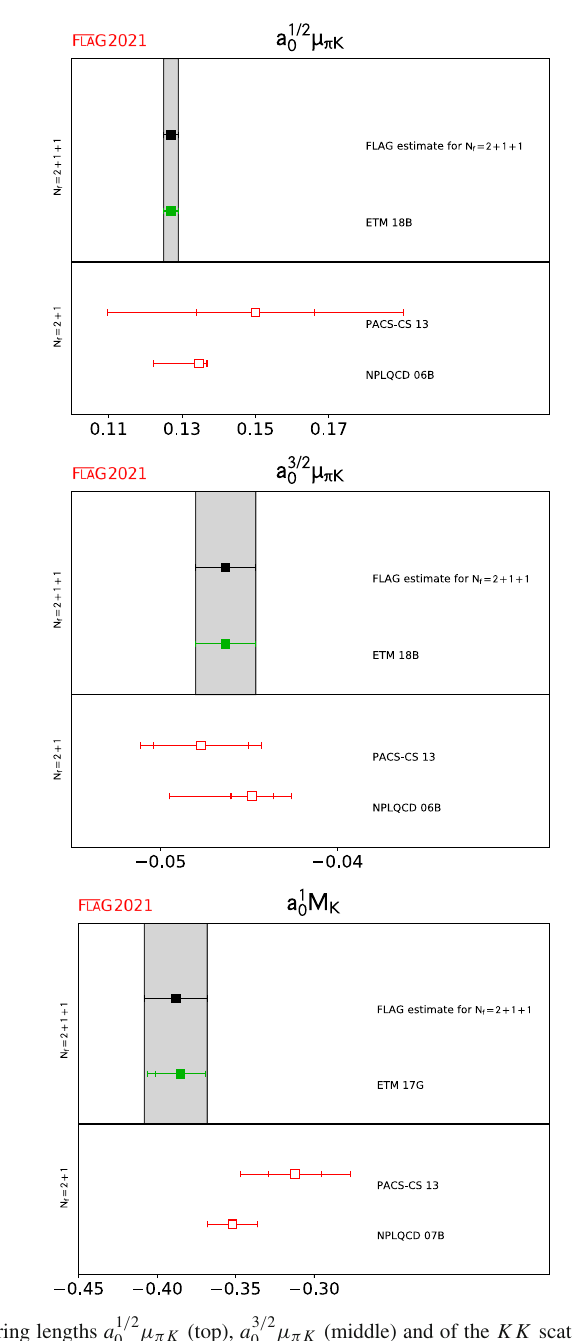
Fig. 19 Summary of the π K scattering lengths a 1 Table 27 with statistical error only are not shown